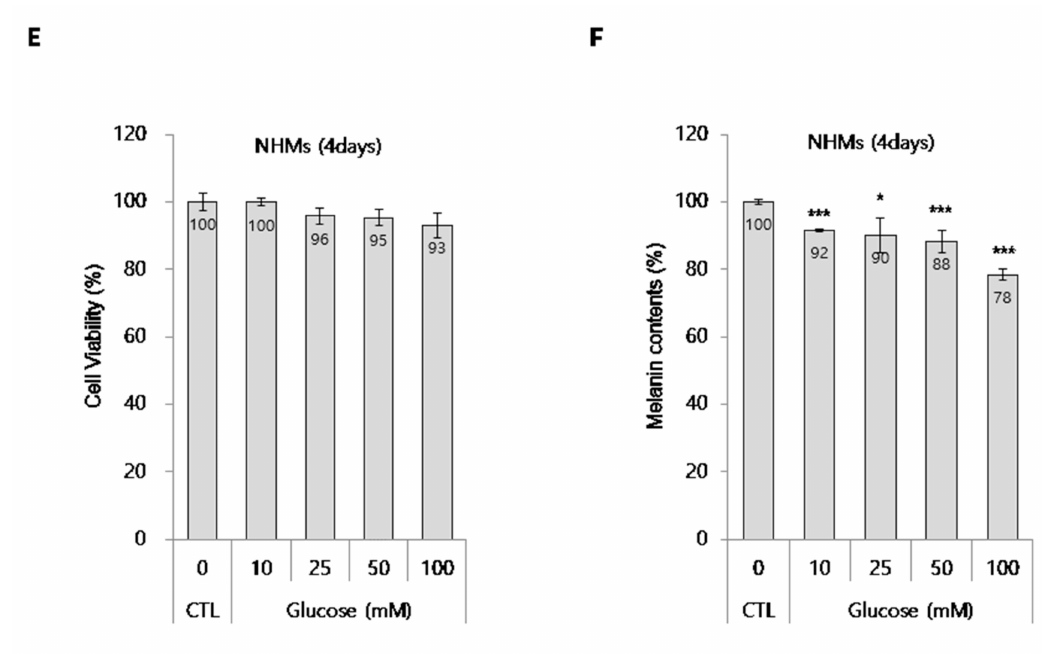
Figure 1. E ff ect of glucose on B16 cells and normal human melanocytes (NHMs). ( A ) E ff ect of glucose on the viability of B16 cells. ( B ) Intracellular melanin contents in α -MSH-stimulated B16 cells. Intracellular melanin contents were determined using cell lysates, as described in the methods section. ( C ) The color of cell lysate. ( D ) Extracellular melanin contents were determined using cultured media containing secreted melanin after glucose and α -MSH co-treatment for 72 h. KA indicates kojic acid (100 µ g / mL), which was used as a reference compound. The photograph shows the colors of culture media. ( E ) E ff ect of glucose on the viability of NHMs. ( F ) E ff ects of glucose on melanin synthesis in NHMs. NHMs were treated with the indicated concentrations of glucose for 4 d, washed, and lysed with NaOH to determine the intracellular melanin contents. The melanin contents were estimated by absorbance at 405 nm and normalized by the total protein contents. Data are expressed as the mean ± SD of at least three independent measurements (* p < 0.05, ** p < 0.01, *** p <